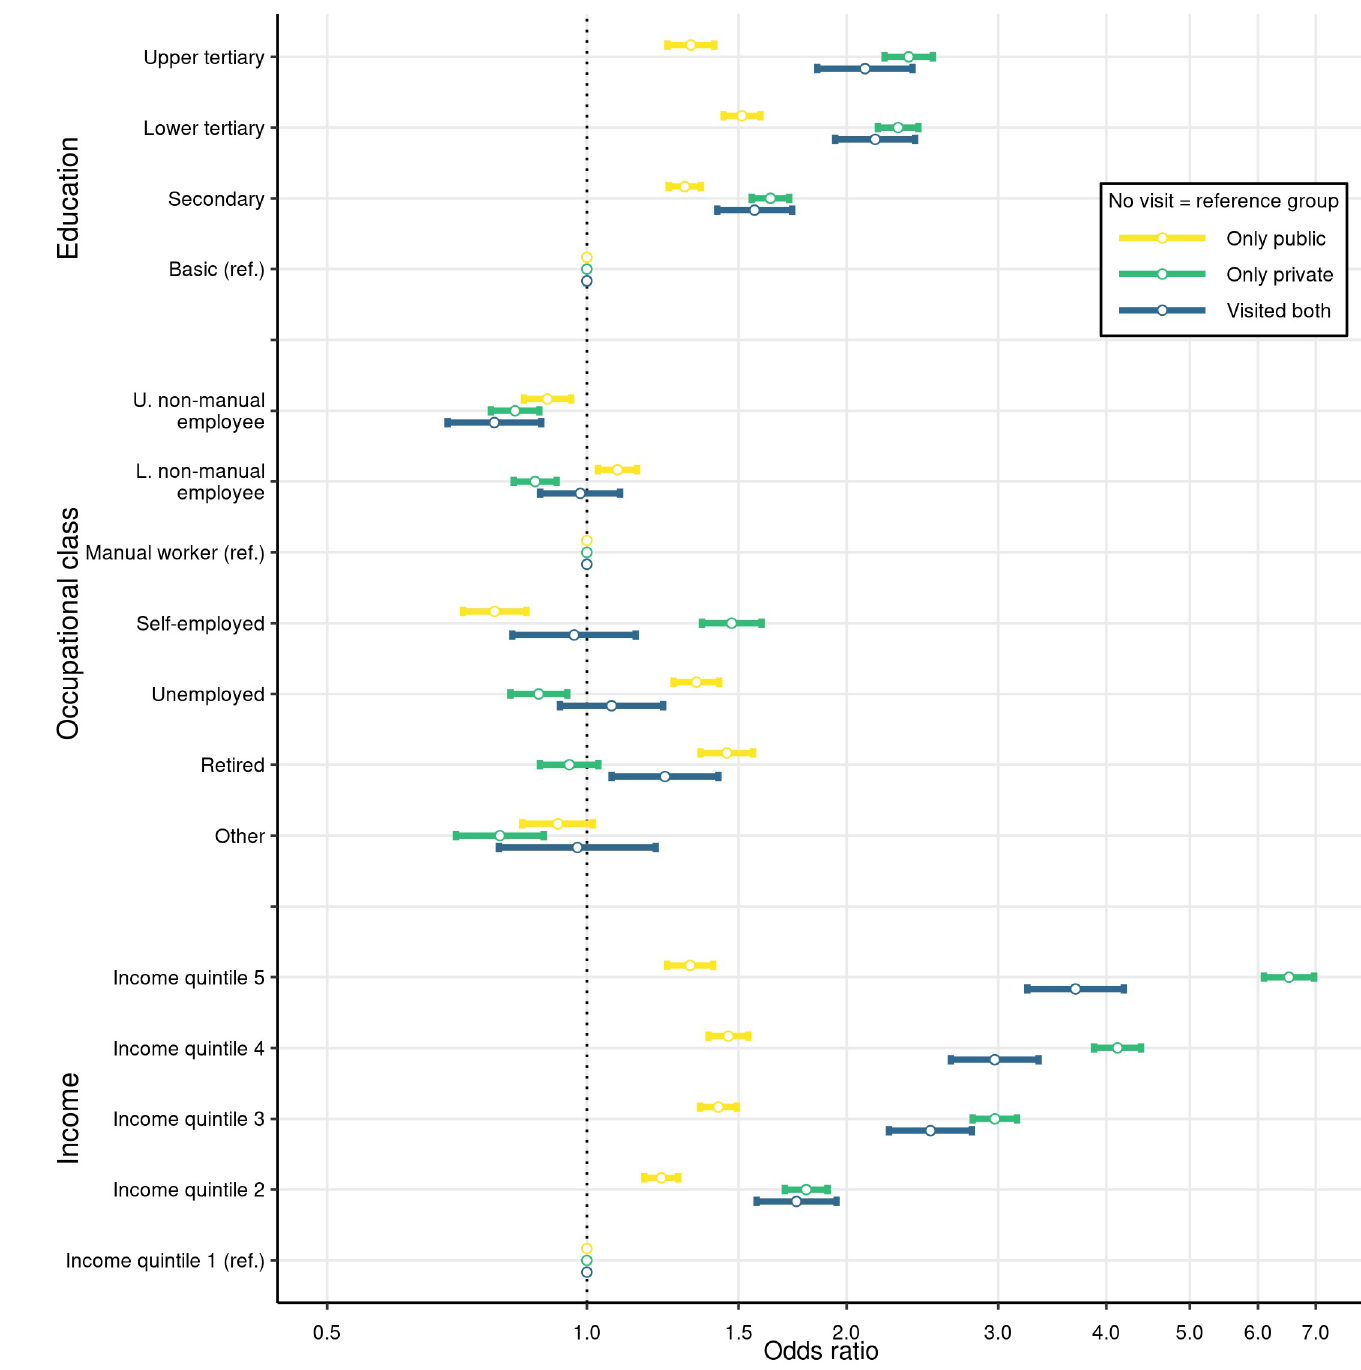
Fig 2. Multinomial logit odds ratios for visiting public, private, or public and private dentists, with their 95% confidence intervals. Study population: non-student (aged over 25) residents of Oulu, Finland, in 2017–2018 (N = 118,397). Other covariates included in the logit model but not shown in the figure are sex and age groups